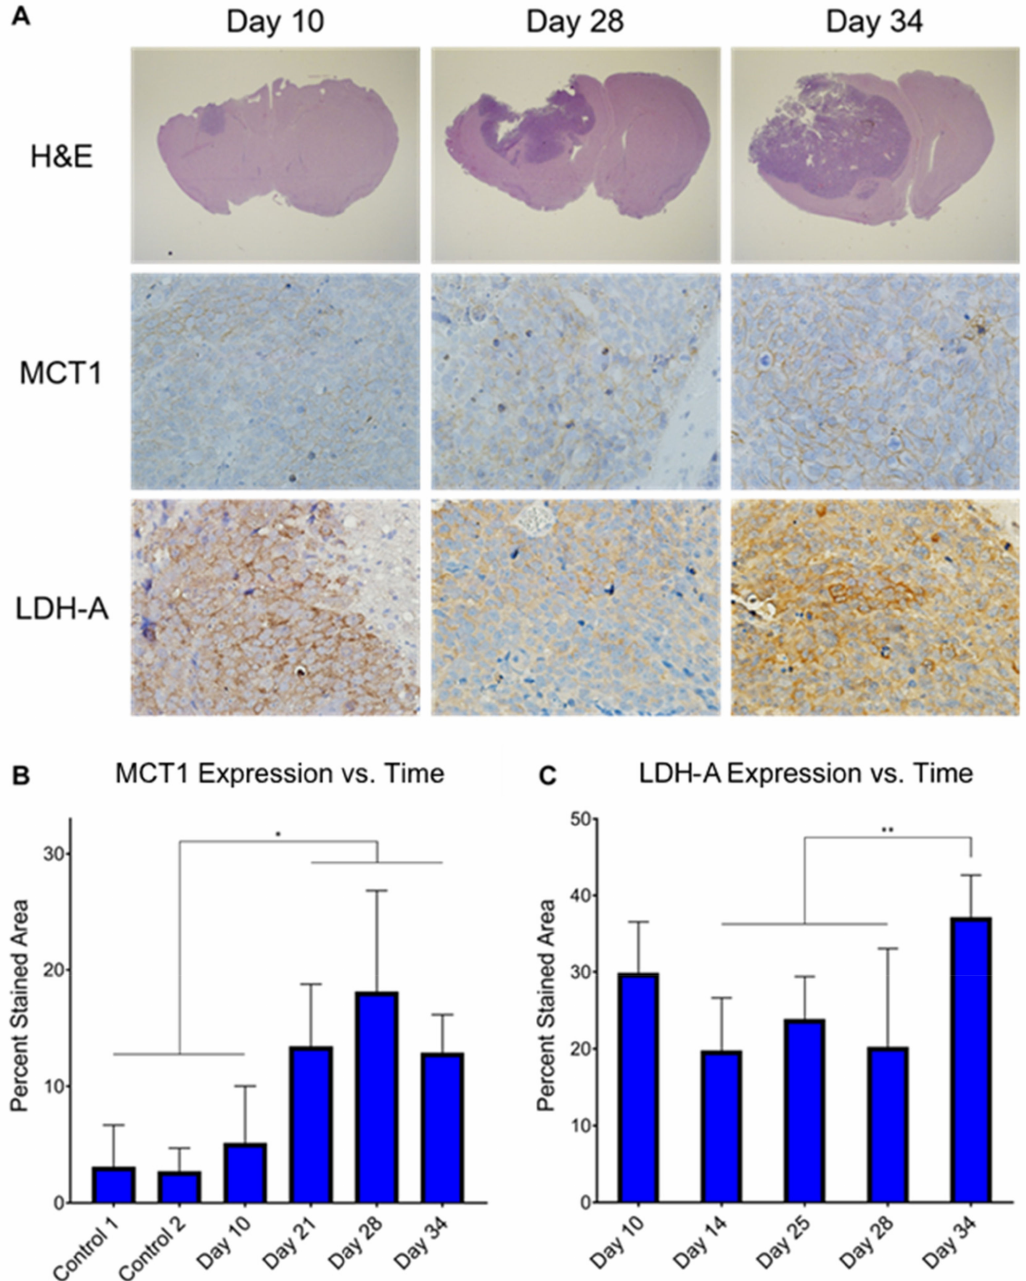
Figure 6. Ex vivo MCT1 expression significantly increases throughout tumor development. Histology stains of H&E, MCT1, and LDH-A were measured in ex vivo untreated tumor samples at several time-points throughout tumor development ( A ). It can be clearly seen that MCT1 is confined to the cell membrane and LDH-A to the cytoplasm. Percent stained area was calculated from the MCT1 ( B ) and LHD-A ( C ) IHC images at these time-points. Average percent stained area between time-points was assessed for significance using ordinary one-way ANOVA and follow-up Fisher’s Least Significant Difference tests with significance attributed to comparisons that produced p < 0.05. * p < 0.05, ** p <